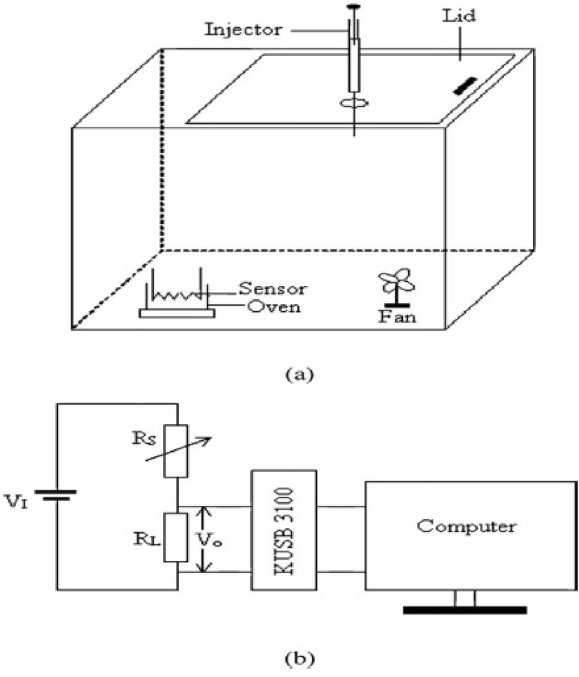
Figure 1. Schematic of sensor unit ( a ) testing chamber ( b ) data acquisition